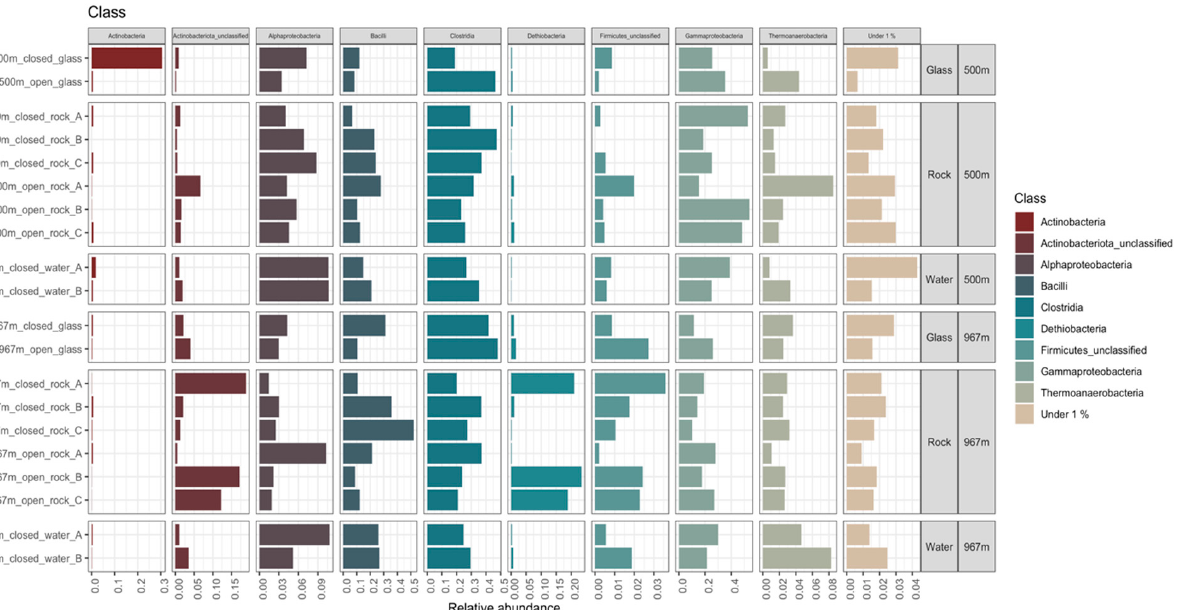
Figure 8. Relative abundance of bacterial phyla from sampling depths 500 and 967 m. All phyla present at less than 0.1% relative abundance are merged as group “Under 0.1%”.